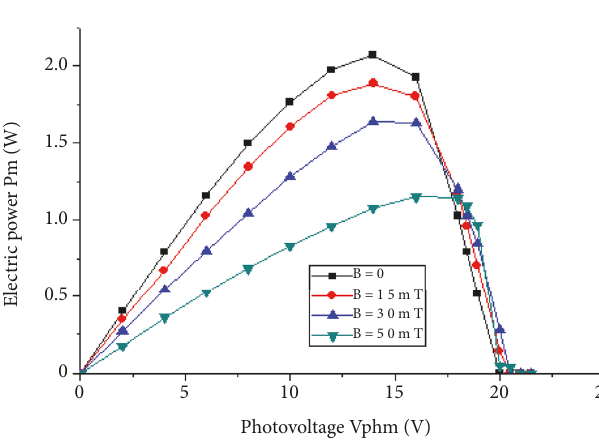
Figure 6: Experimental power versus voltage at different intensity of the magnetic